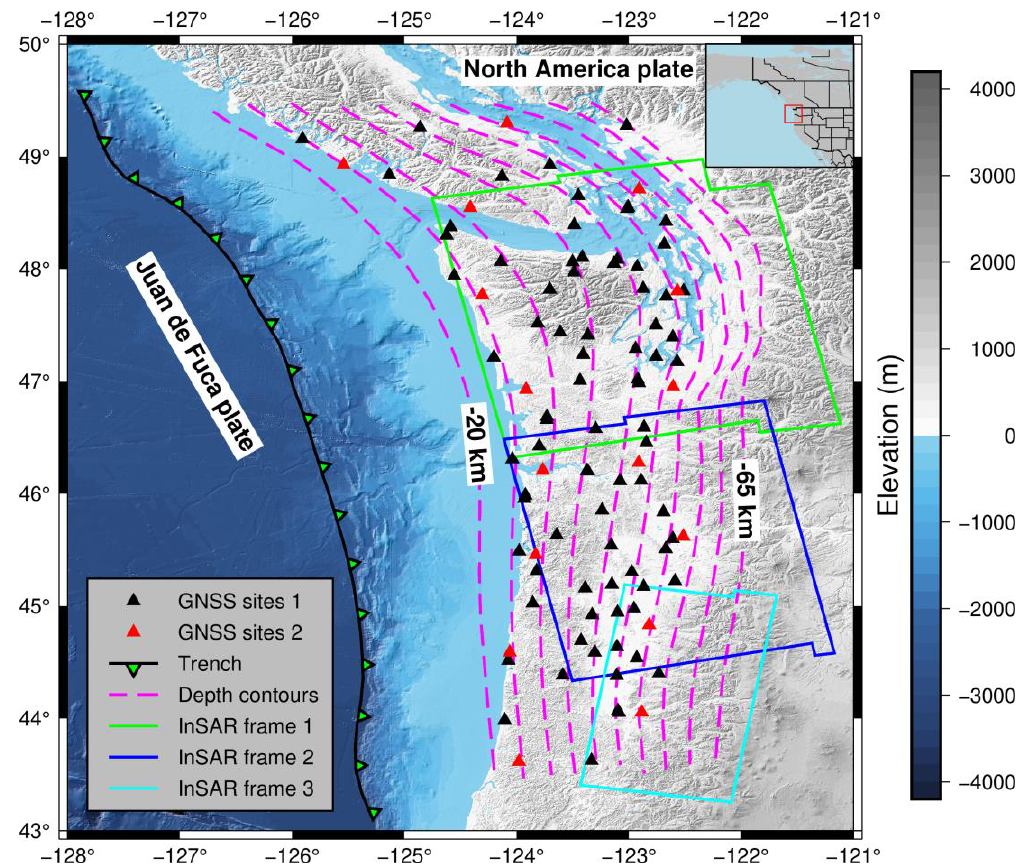
Figure 7. Spatial distributions of topography, global navigation satellite system (GNSS) sites, interferometric synthetic aperture radar (InSAR) data range, and depth contours of the Cascadia subduction zone. The red box in the upper right inset depicts the study area. Triangles represent GNSS site locations; black triangles represent the 97 dense GNSS sites of the first experimental scheme in Section 3.2.2 and red triangles represent the 16 sparse GNSS sites of the second and third experimental schemes. Pink dashed line indicates the location of the depth contours from −20 km to −65 km in steps of −5 km. Red, blue, and cyan solid lines represent the coverage of InSAR tracks 137 and 115 used in the experiment, with the right boundary of each frame determined by the −65 km depth contour.